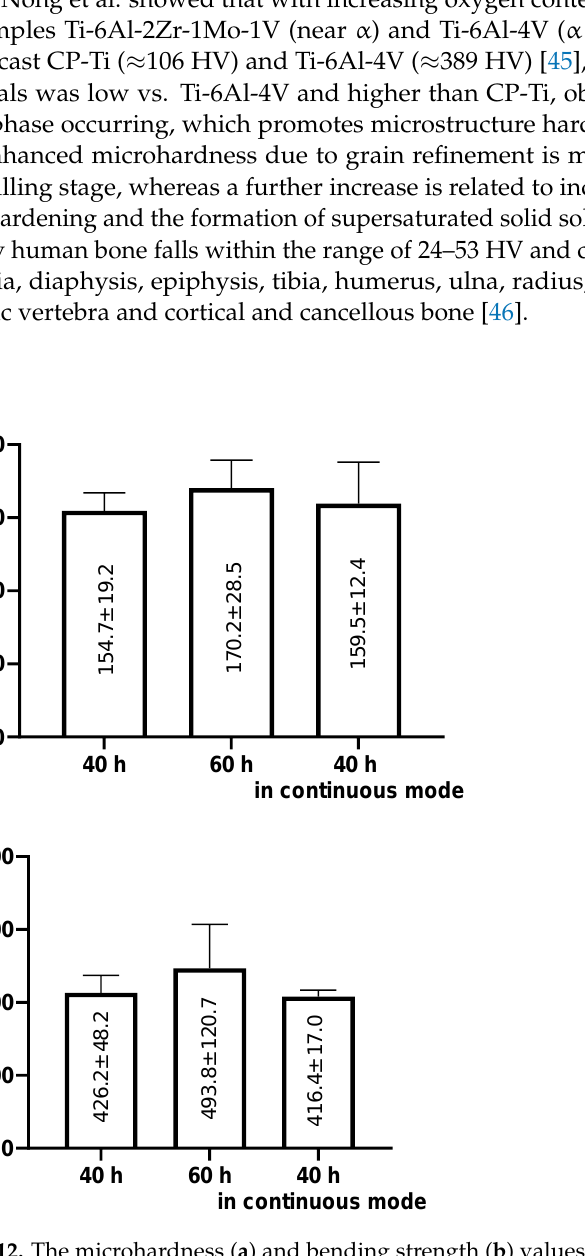
Figure 12. The microhardness ( a ) and bending strength ( b ) values of the sintered parts previously milled at 40 h, 60 h and 40 h in the continuous